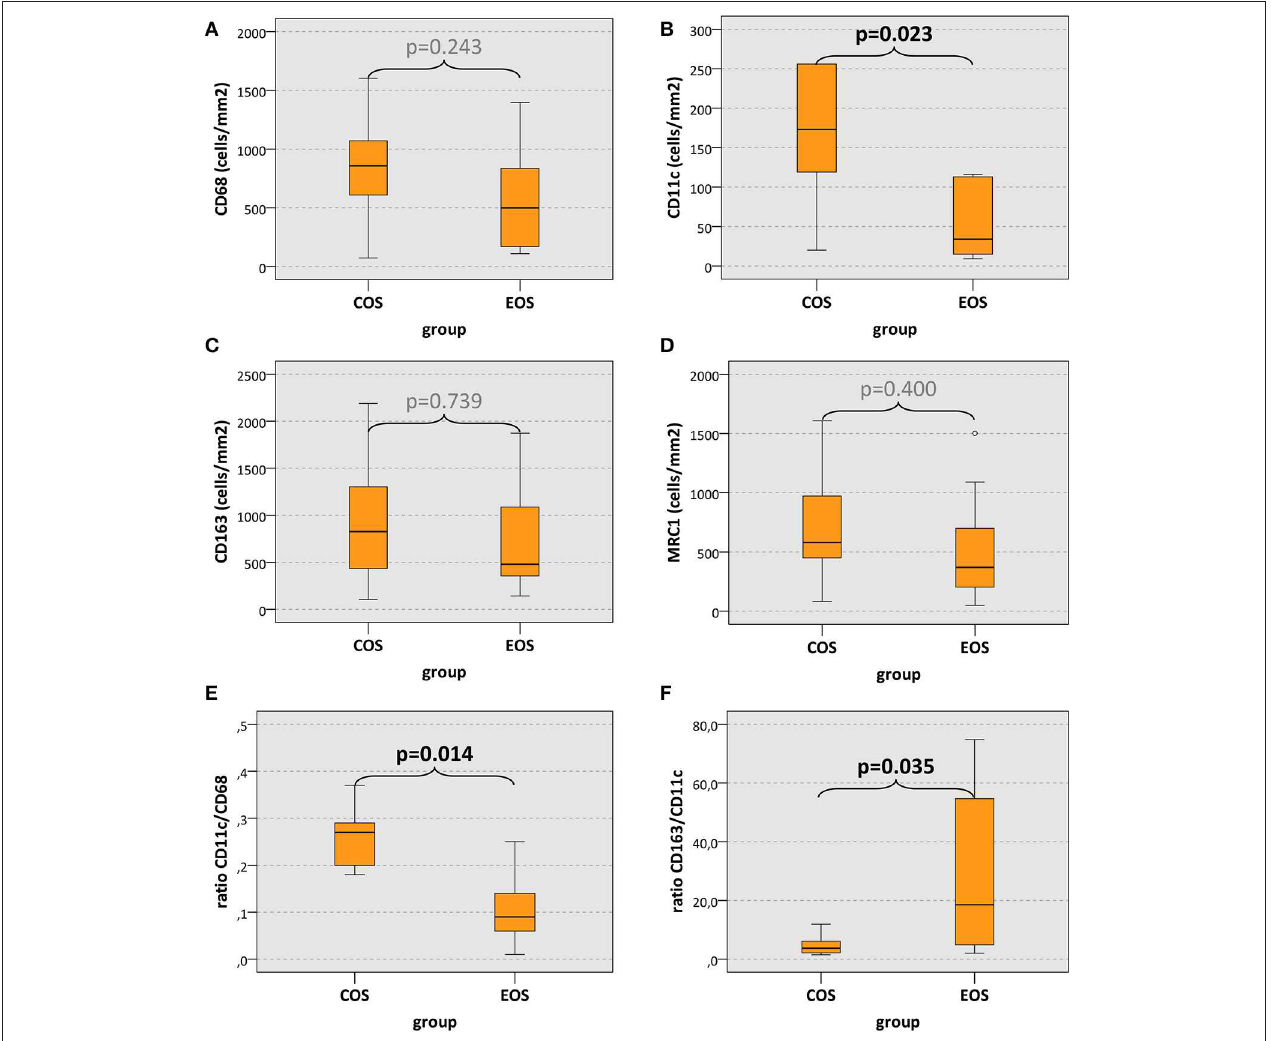
FIGURE 3 | Macrophage cell count and macrophage expression ratios. (A–D) The box plots show macrophage infiltration (positive cells/mm 2 ) and (E,F) macrophage expression ratios in craniofacial osteosarcomas (COS) and extracranial osteosarcomas (EOS). p values generated by the Mann–Whitney U test are given. Significant p values are printed in “bold”